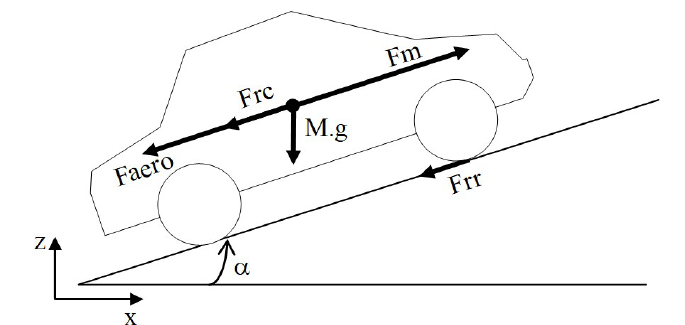
Figure 2. Forces affecting vehicles in